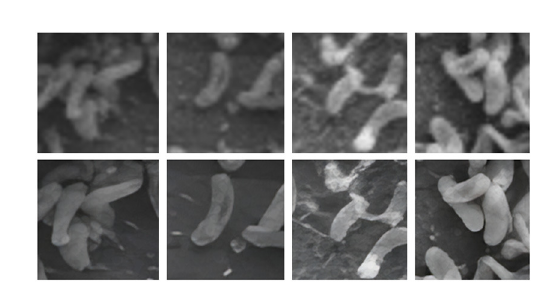
FIGURE2 Output patches after super-resolution method. Top row contain patches from original image patches. Bottom row contains patches after applying super-resolution.